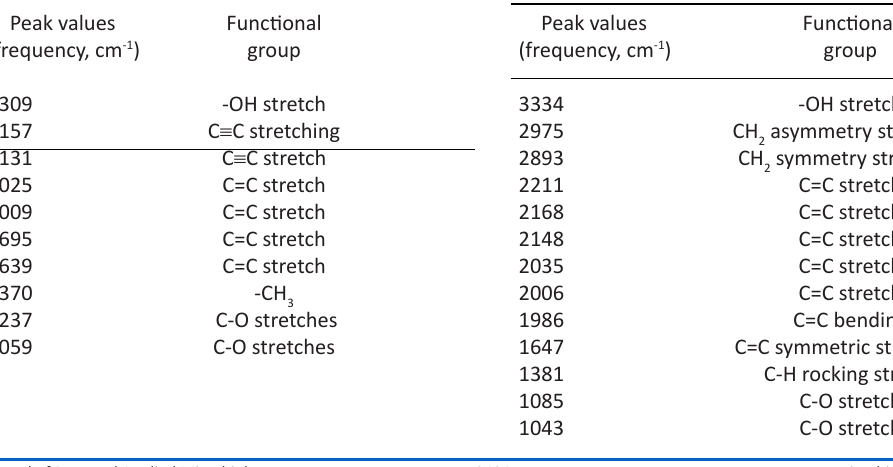
Table 7. IR Spectrum for passion fruit ethanol extract Table 6. IR Spectrum for passion fruit with pulp and